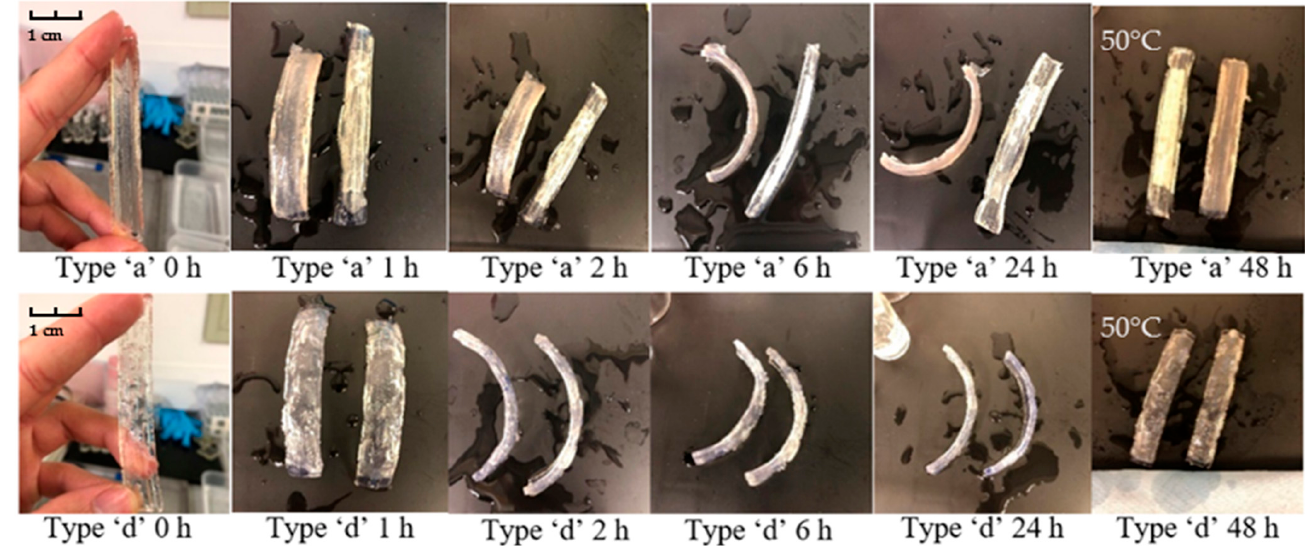
Figure 8. The appearance of swollen type ‘a’ and ‘d’ bilayer samples at times: 0 h; 1 h; 2 h; 6 h; 24 h and 48 h (50 °C).